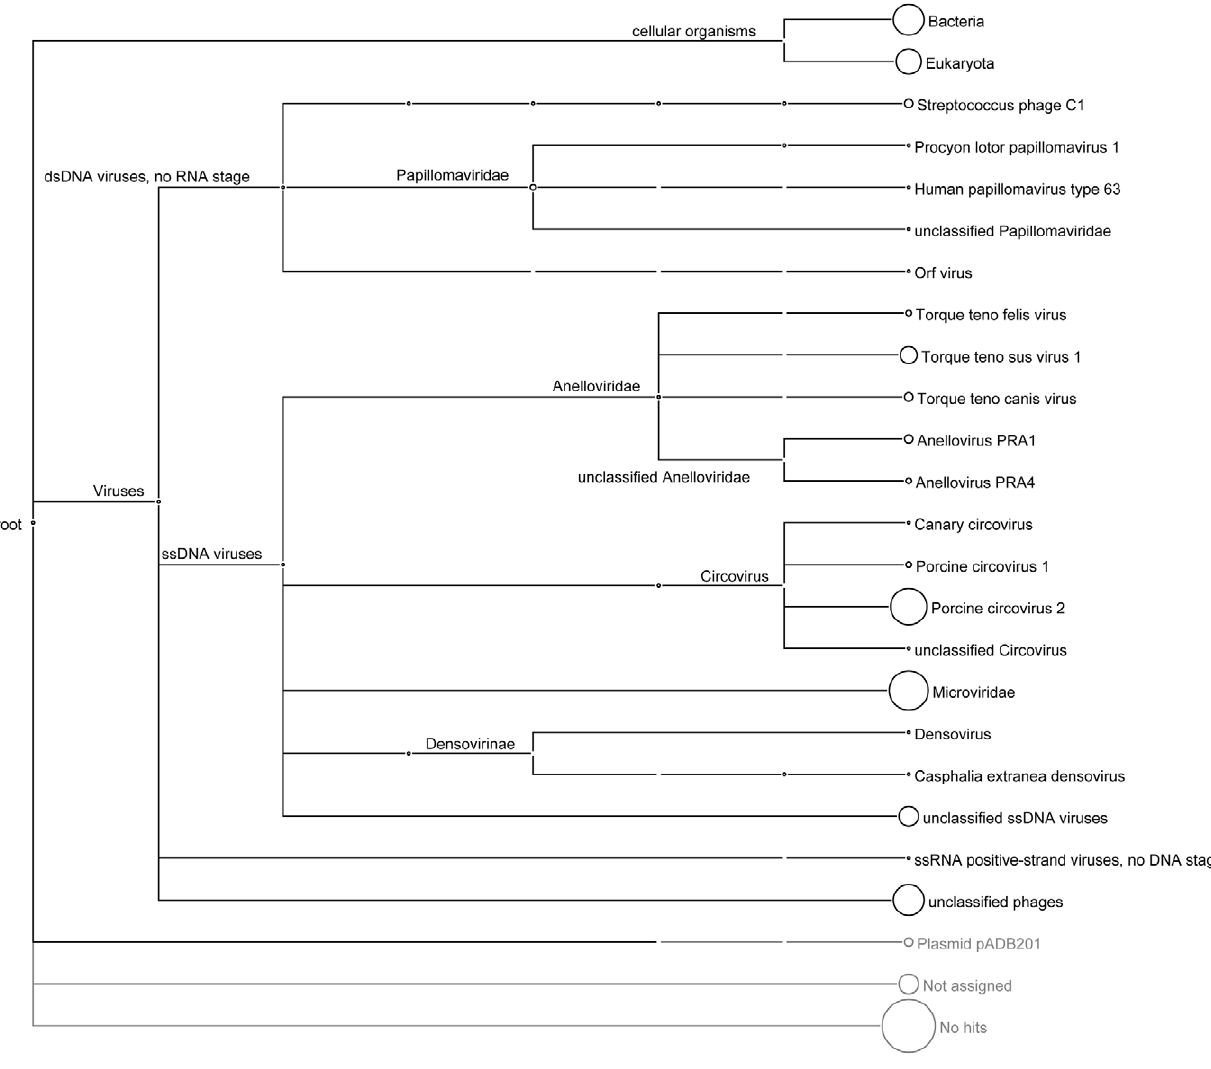
Figure 1. MEGAN tree with taxonomic assignments. The distribution of the sequence reads through blastx analysis against the nr database. Size of circles located next to taxa are proportional to the total number of reads identified. Not assigned contains those reads that are not assigned by the least common ancestor algorithm. No hits contains those reads that did not return any significant alignments to the nr database.